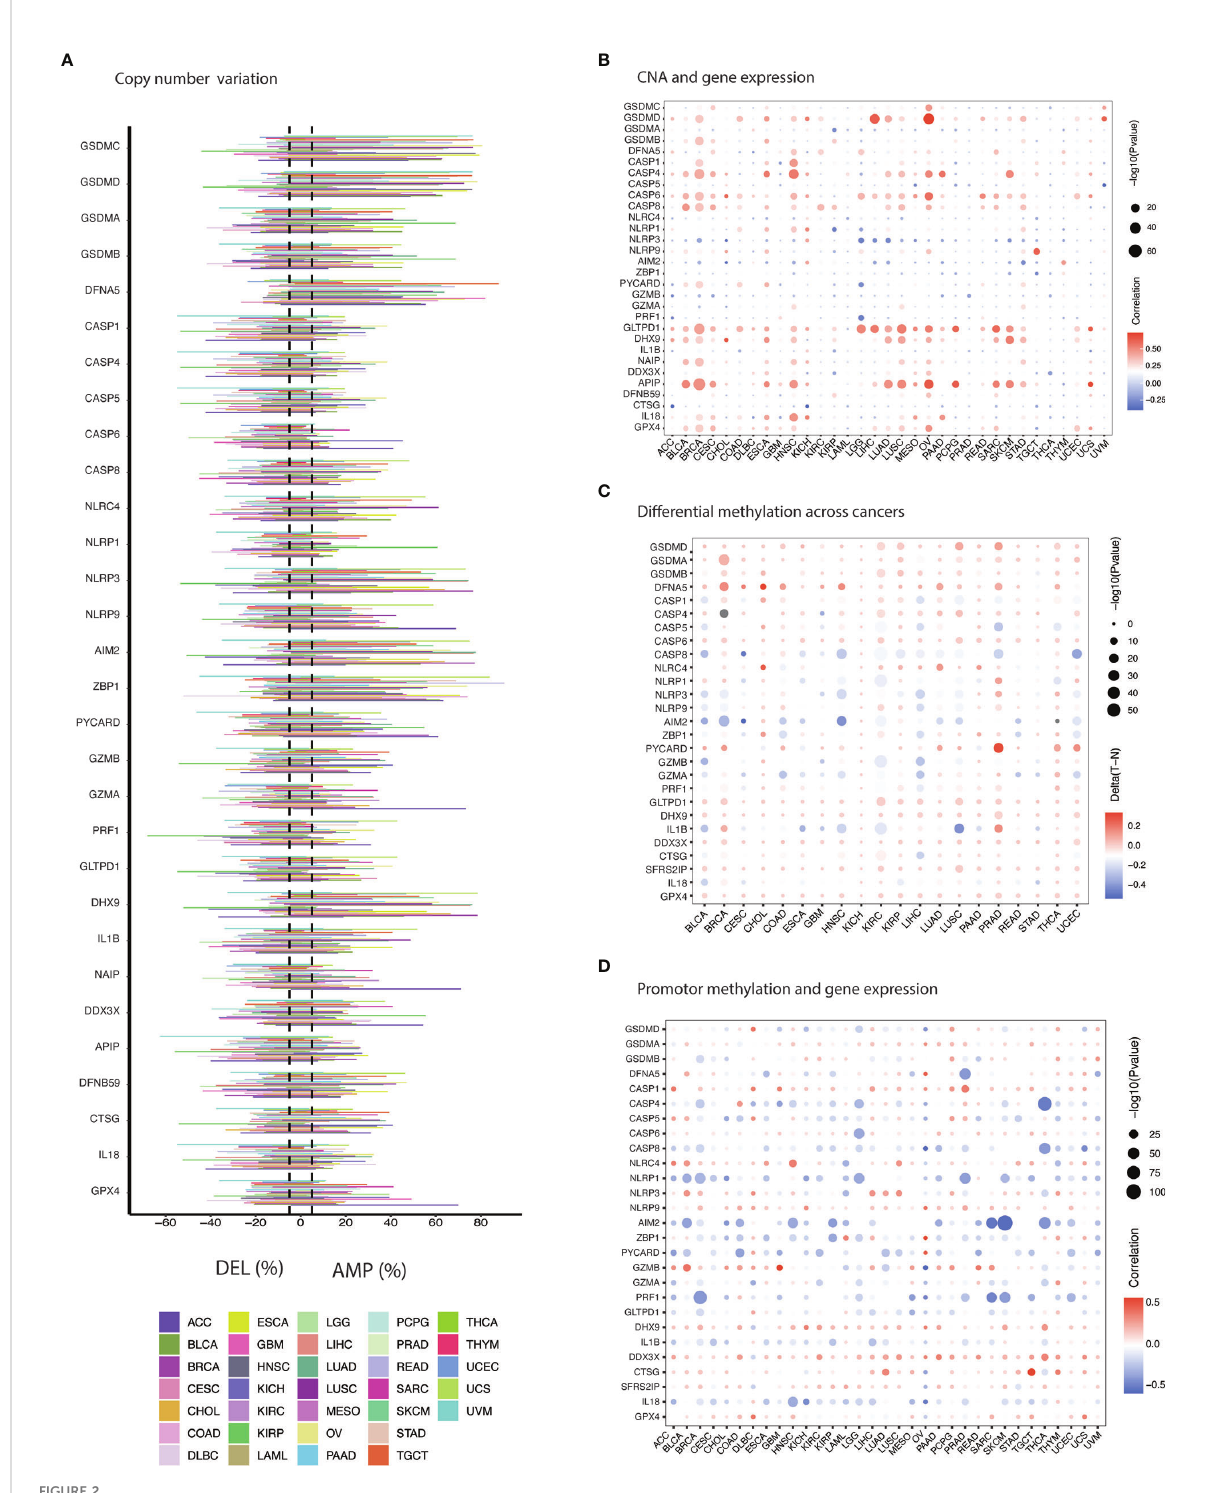
FIGURE 2 Genomic & epigenetic aberrations in PRGs. (A) Histogram illustrates frequency of copy number alteration (deletion/ampli fi cation) for each PRG across cancers. (B) The Spearman ’ s correlation between copy number variation (CNV) and the expression of PRGs. Blue & red represent negative & positive correlation respectively. (C) Heatmap shows the methylation difference between tumor and normal tissues. Red and blue indicate hypermethylation and hypomethylation in cancers, respectively. (D) Pearson ’ s correlation showing association between methylation and gene expression. Blue & red represent negative & positive correlation